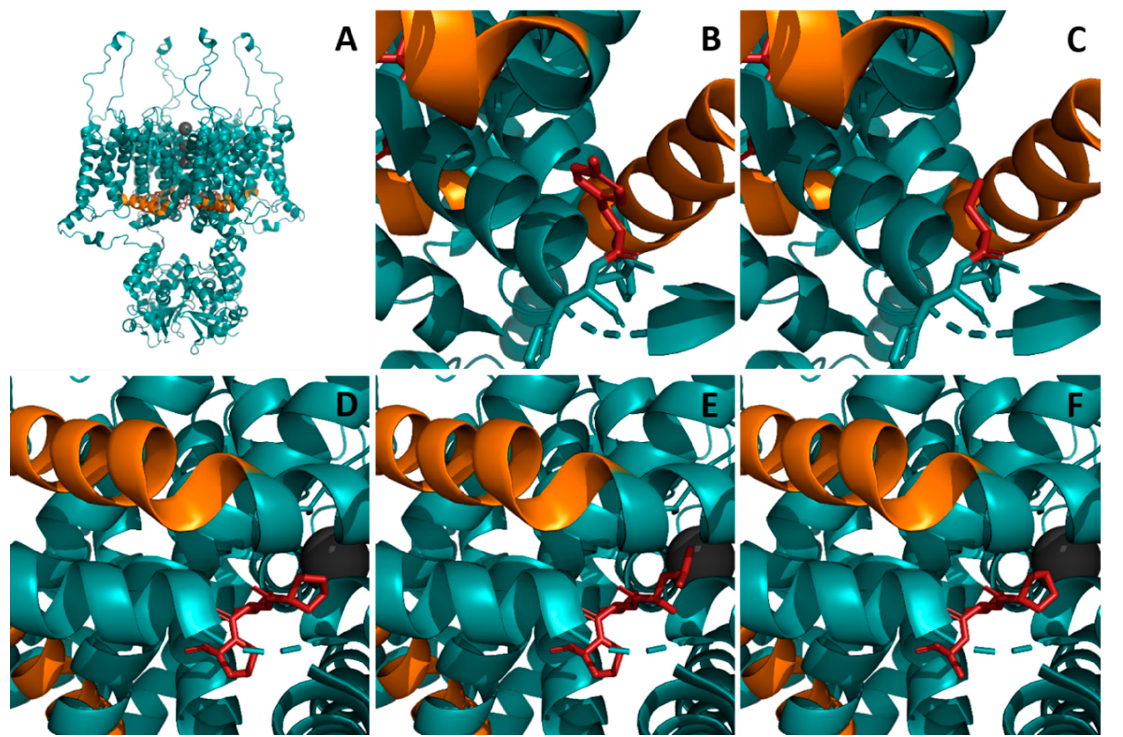
Figure 1. Localization of three identified missense variants in the K v 1.2 channel. Three-dimensional (3D) protein structure of the K v 1.2 channel shown as a ribbon model. ( A ) Lateral overview of the channel tetramer (turquoise) and three potassium ions localized in the channel pore (spheres, gray). The residues Pro405, Pro407, and Tyr417 are shown in stick representation (red). The S4-S5 linker is highlighted in orange. ( B ) Close-up view of residue Tyr417 and ( C ) the mutated residue Cys417 (red sticks), in context with the S4-S5 linker regions of the same and neighboring channel subunits, respectively (orange). ( D – F ) Close-up views of the proline(405)–valine(406)–proline(407) (PVP) motif (red sticks; ( D )) as well as the amino acid substitutions Leu405 ( E ) and Ala407 ( F ) of the corresponding proline residues. The PVP motif interacts with the S4–S5 linker, and both prolines of this symmetric motif ( D ) are important for channel gating. The substitution of Pro405 ( E ) and Pro407 ( F ) disrupts its symmetry and structure, likely impairing interactions with S4–S5 during gating-related conformational changes. All three substitutions are located in the S6 helix and in proximity to the S4–S5 linkers, which is suggestive for the probable affection of associated interactions leading to altered channel gating.